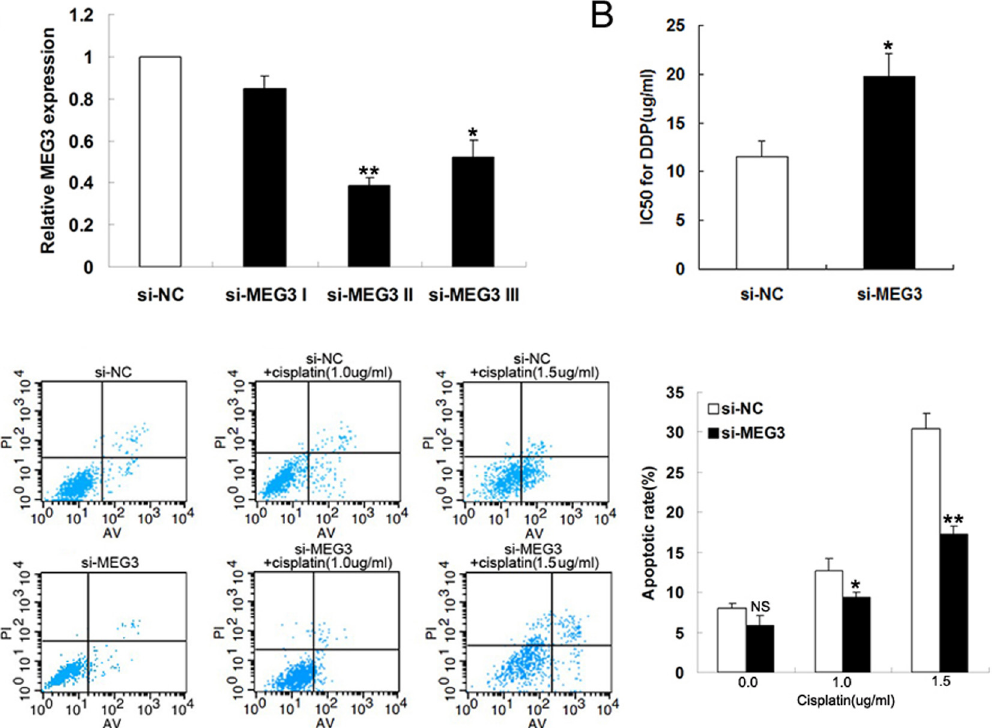
Fig 4. Knockdown of MEG3 inhibits A549 cell apoptosis in vitro . (Fig 4A) qRT-PCR analysis of MEG3 expression levels following the transfection of A549 cells with si-NC and si- MEG3 . (Fig 4B) IC 50 values of si-NC- and si- MEG3 -transfected A549 cells to cisplatin. (Fig 4C) Flow cytometry analysis of apoptosis in si-NC- and si- MEG3 -transfected A549 cells treated with increasing concentrations of cisplatin (0.0, 1.0, and 1.5 μ g/ml). * P < 0.05, ** P < 0.01.